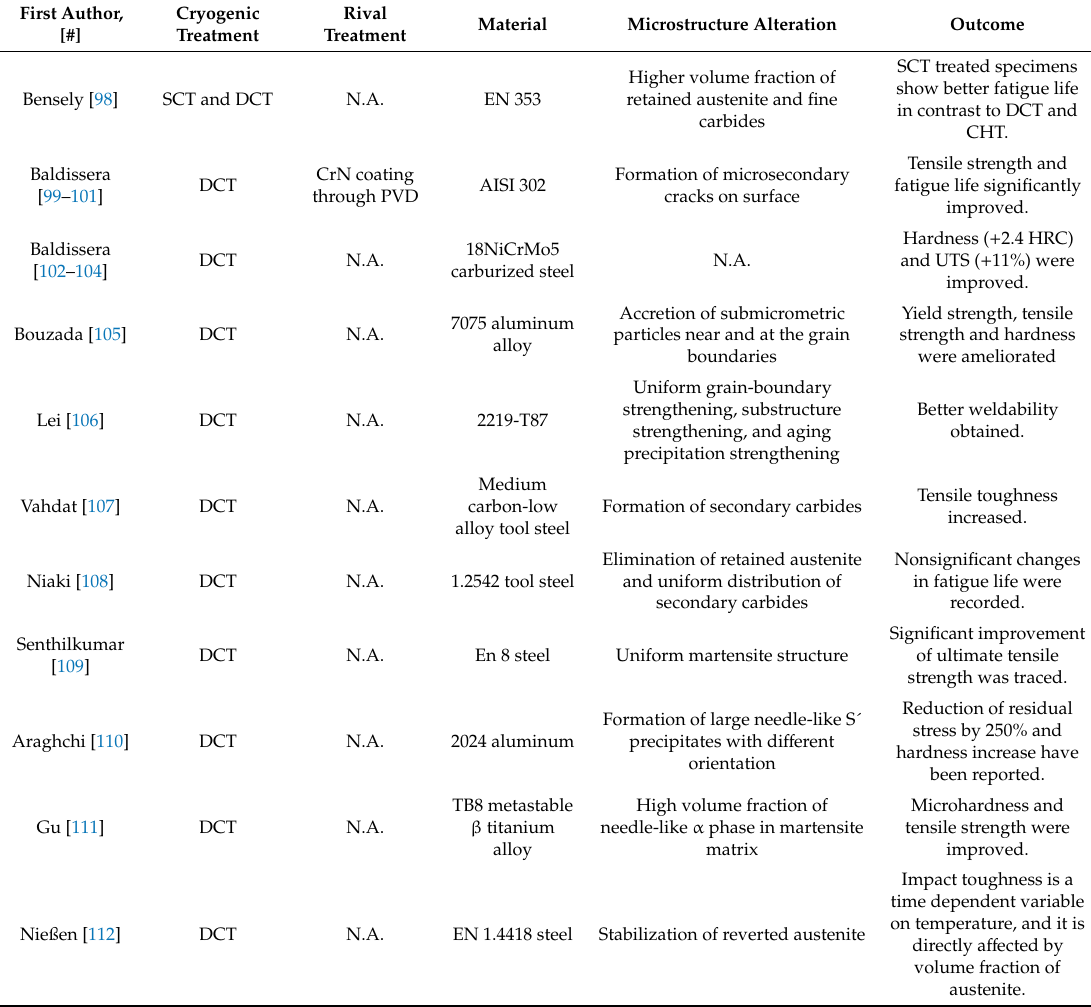
Table 3. Summary of literature data devoted to study the e ff ects of cryo-treatment on microstructure and mechanical